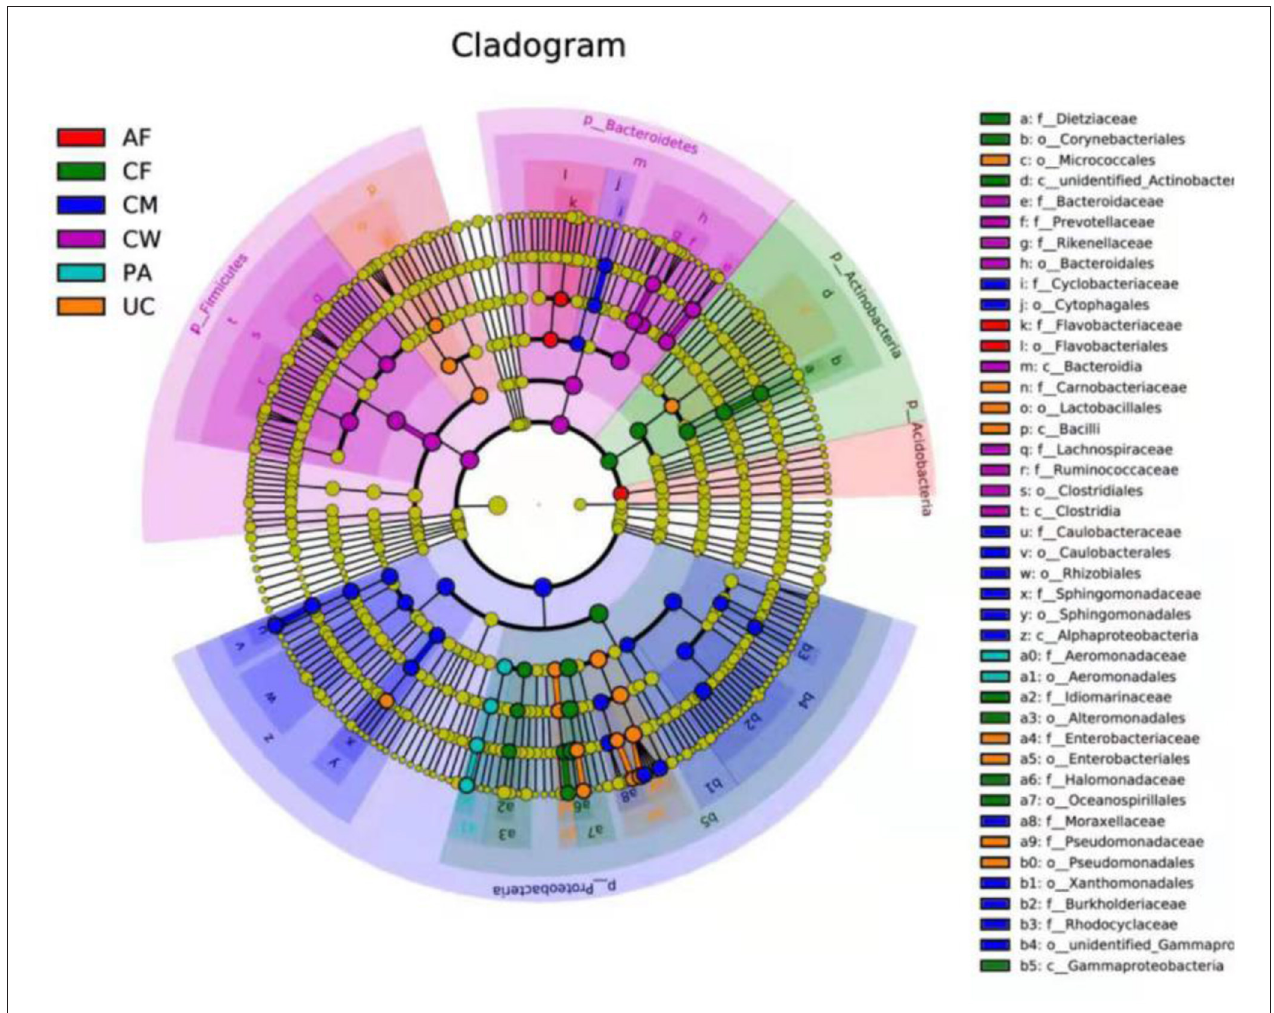
FIGURE 5 | LEfSe-derived phylogenetic trees of the microbiome in all different sample types. AF, amniotic fluid; CF, calf meconium; CM, colostrum; CW, cow feces; PA, placenta; UC, umbilical cord.